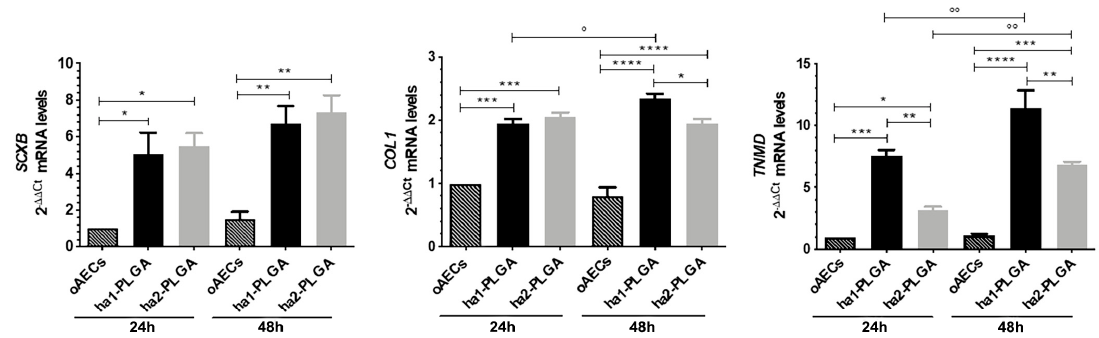
Figure 9. Teno-inductive properties of ha-PLGA fleeces on AECs. SCX, COL1, and TNMD gene expression were evaluated at 24 h and 48 h culture points. Quantitative RT-PCR data show a significantly higher expression of tenogenic markers in oAECs seeded onto ha-PLGA fleeces compared to oAECs on Petri dishes (reference sample oAECs at 24 h = 1) (n = 3 for each type of sample / analysis / time point, fleece size: 15 mm × 7 mm). * Statistically significant among the di ff erent groups at each time point ( p < 0.05). ** Statistically significant among the di ff erent groups at each time point ( p < 0.01). *** Statistically significant among the di ff erent groups at each time point ( p < 0.001). **** Statistically significant among the di ff erent groups at each time point ( p < 0.0001). ◦ Statistically significant within the same group at di ff erent time points ( p < 0.05). ◦◦ Statistically significant within the same group at di ff erent time points ( p <